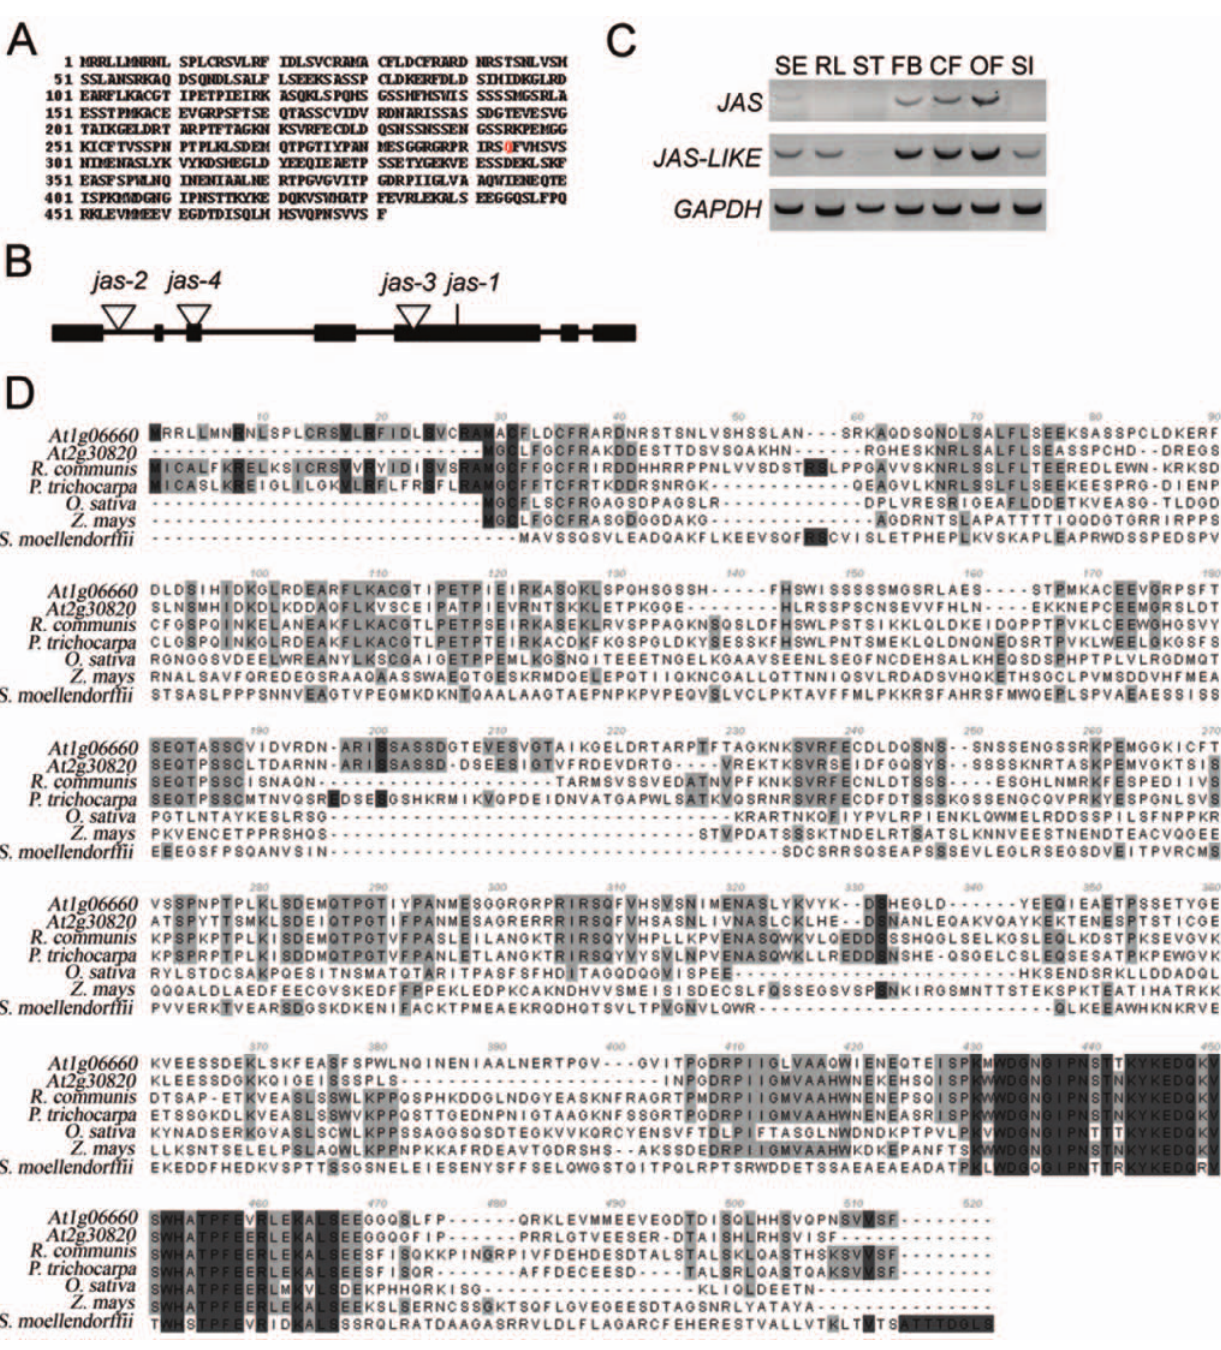
MEA is biallelically expressed in the embryo, but exclusively maternally expressed in the endosperm [28]. As embryo develop- ment in triploid jas seeds is delayed, we wondered whether decreased transcript levels of MEA in jas seeds were caused by